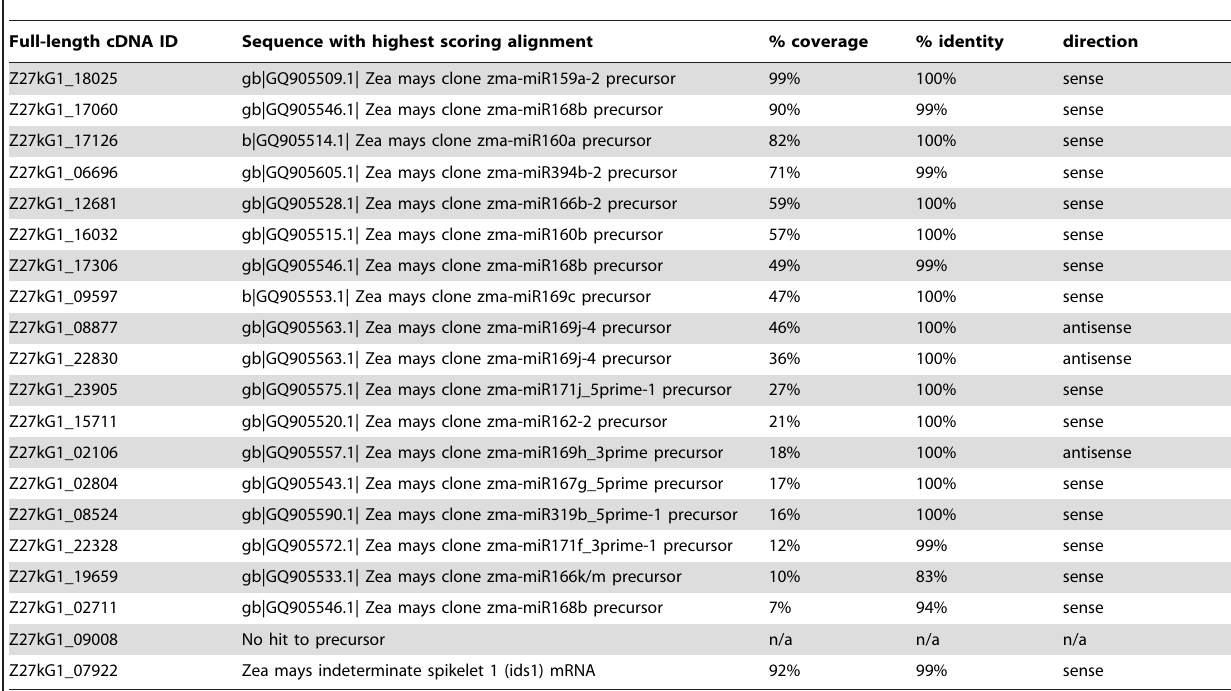
Table 2. Homology of miRNA precursors with previously classified miRNA precursor sequences.